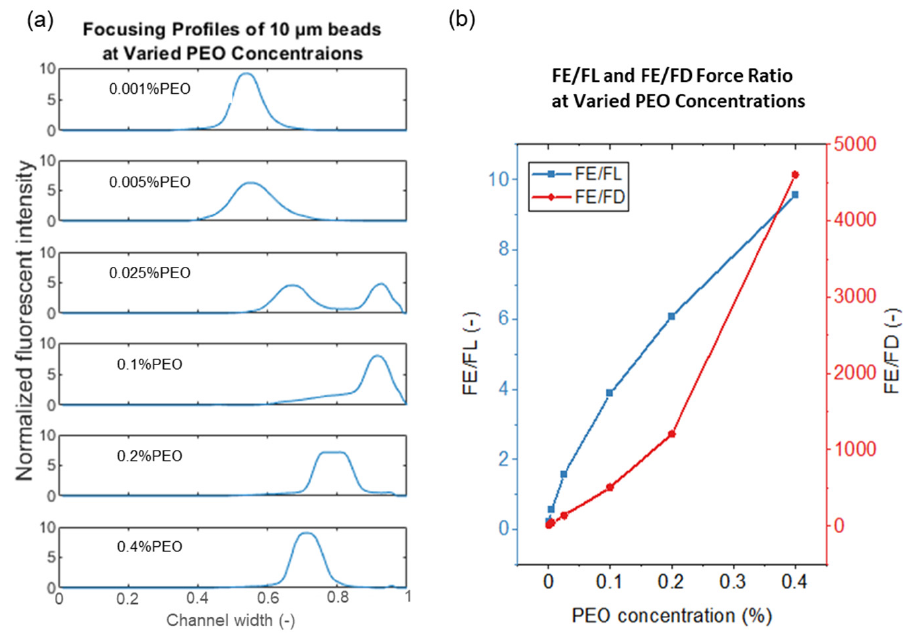
Figure 8. ( a ) Effect of PEO concentration on the focusing of 10 µ m beads at a constant flow rate of 0.2 mL/min. The PEO increases in each figure from top to bottom with the absolute value shown in the legend. The x-axis shows the normalized channel width from the channel inner side wall to the outer side wall. ( b ) Force ratio of F E /F L and F E /F D for 10 µ m beads.